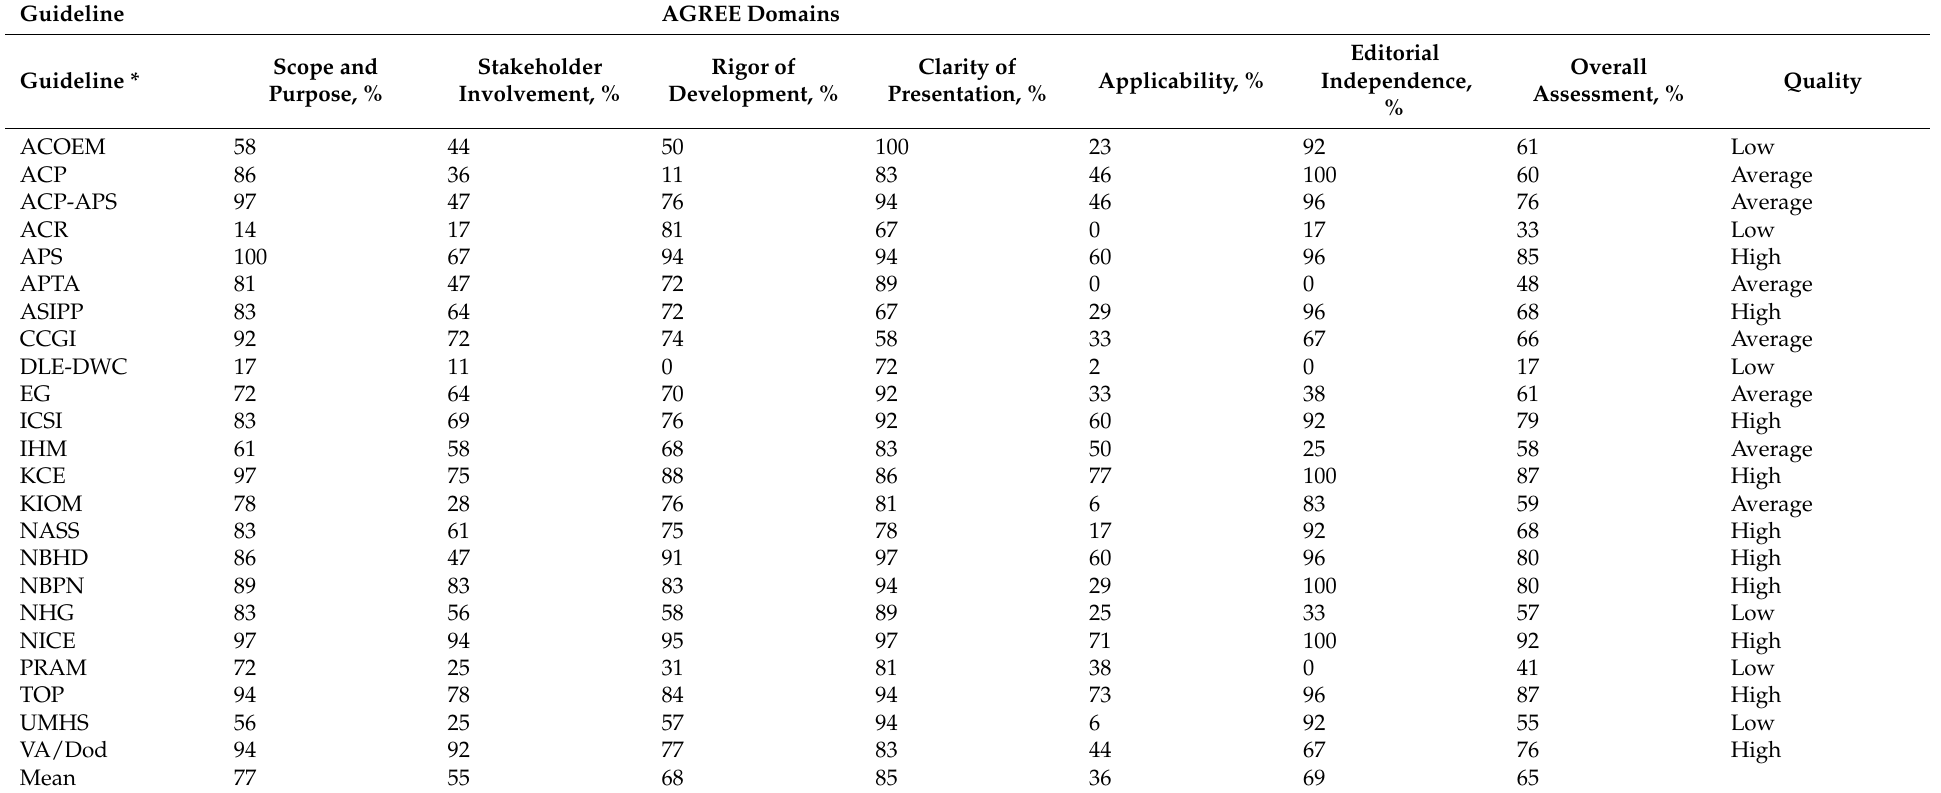
Table 2. Appraisal of Guidelines Research & Evaluation (AGREE ) II domain scores and quality of the eligible guidelines ( n =